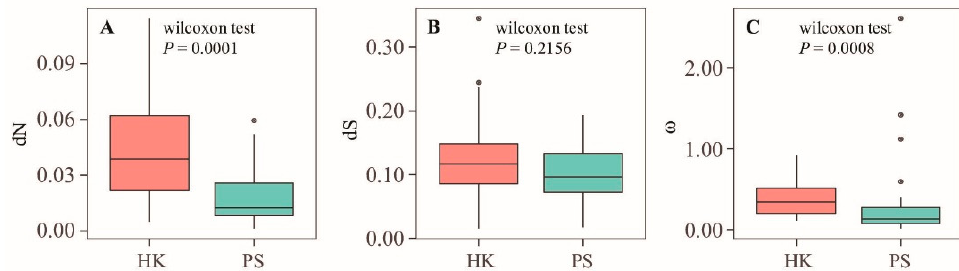
Figure 7. Comparison of the d S , the d N , and the ω values between the chloroplast primary PS and HK genes within clade Myrsinaceae s.str.; ( A ) boxplot of the d N values, ( B ) boxplot of the d S values, ( C ) boxplot of the ω values. The p -values were calculated by non-parametric Wilcoxon rank sum tests in R.